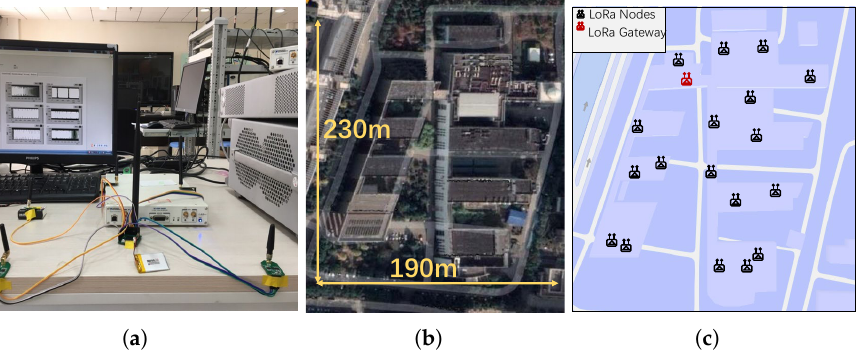
Figure 8. Experimental setup. ( a ) BackLoRa tags with USRP X310. ( b ) Experimental site map. ( c ) Floor plan with the location of gateways and nodes